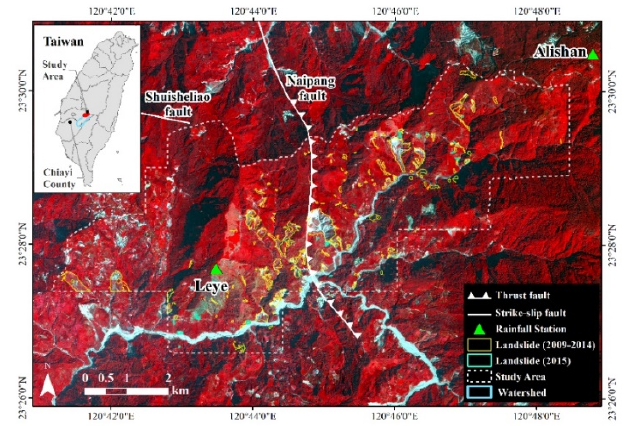
Figure 1. Map of the study region showing the reference landslide areas during 2009−2015 used for RF model training and accuracy assessment with reference to the false-color SPOT-5 image on 5 March 2015 (RGB = 3, 2, 1).